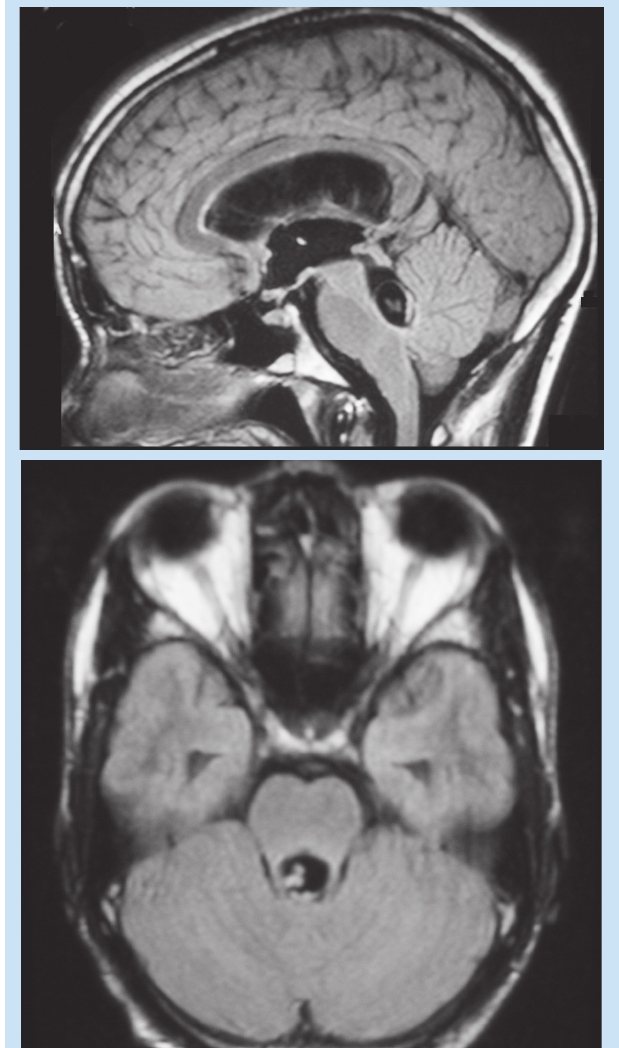
Figs. 2a and b. Sagittal and axial FLAIR MR images clearly demonstrating the 4th ventricular neurocysticercus cyst and the eccentric scolex. The hydrocephalus is markedly improved post-3rd ventriculostomy.